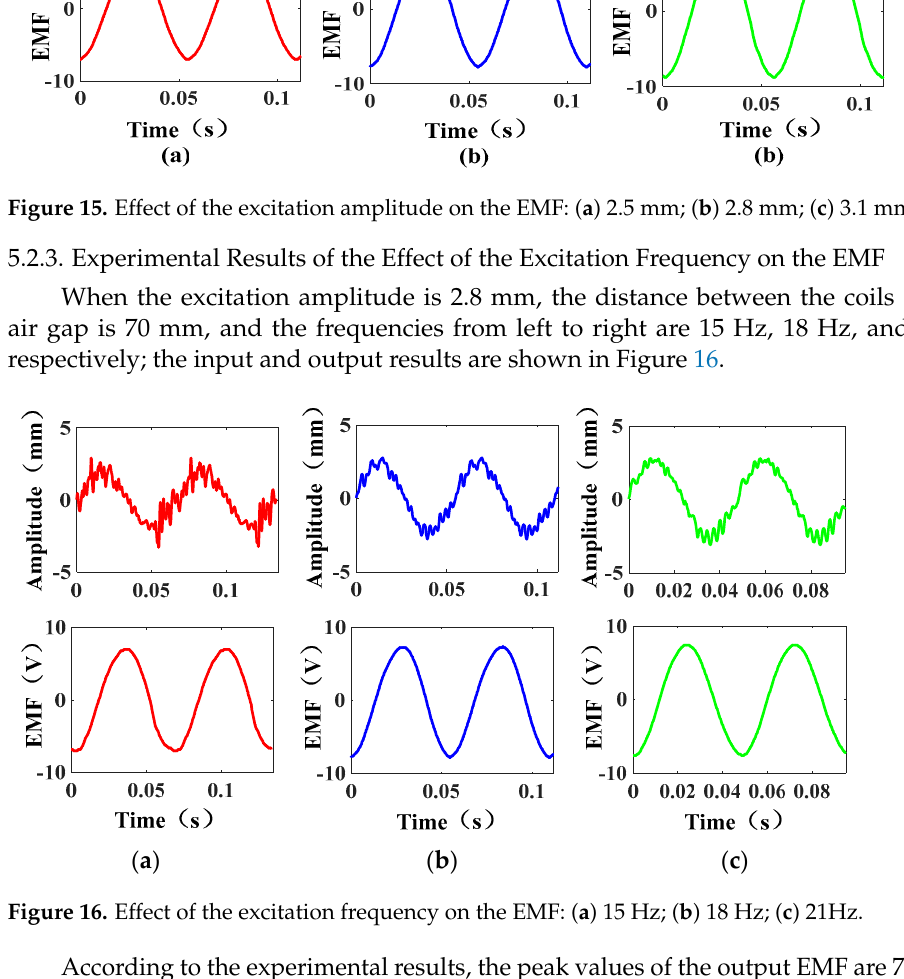
Figure 15. Effect of the excitation amplitude on the EMF:( a ) 2.5 mm; ( b ) 2.8 mm; ( c ) 3.1 mm.